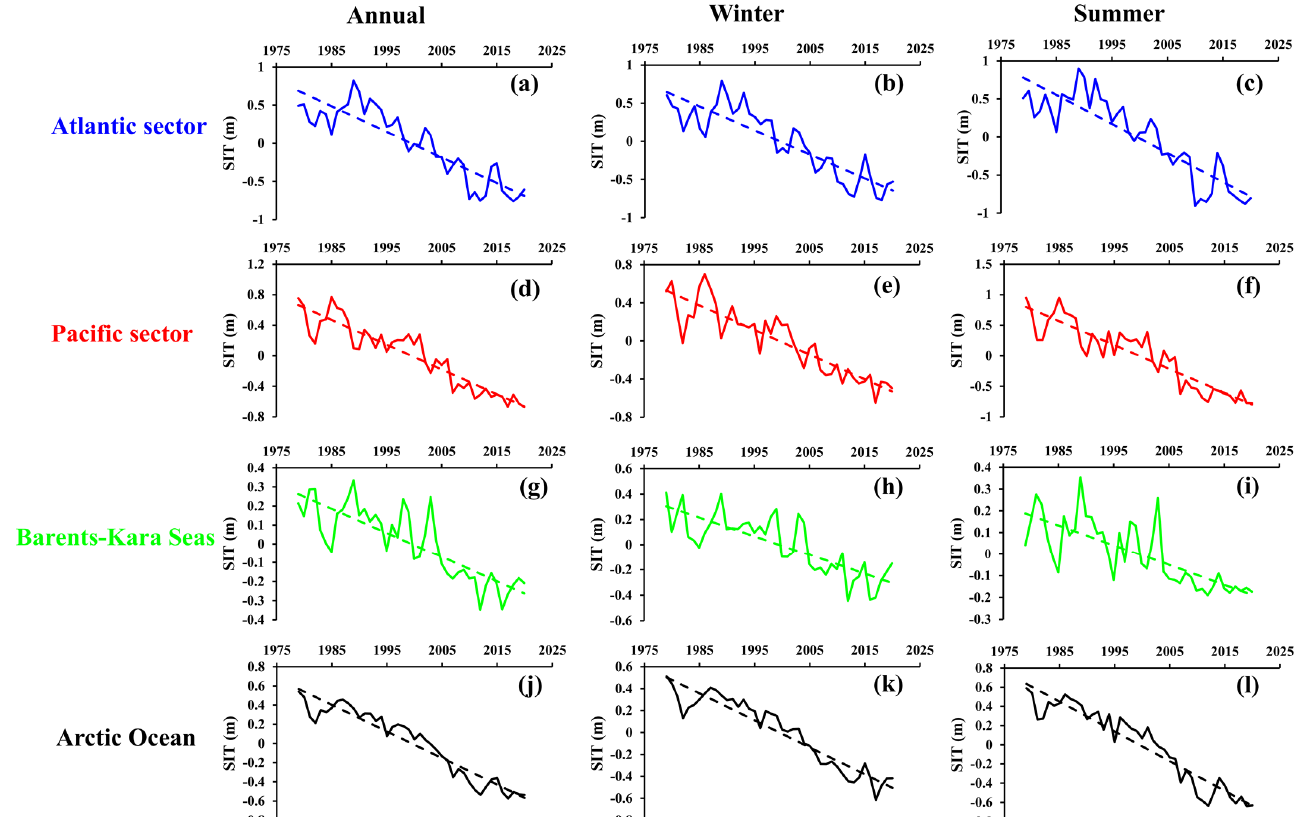
Figure 6. The annual and seasonal time series of sea ice thickness (SIT) anomaly in 1979–2020 for the Atlantic sector ( a – c ), Pacific sector ( d – f ), Barents–Kara Seas ( g – i ) and the Arctic Ocean ( j – l ).